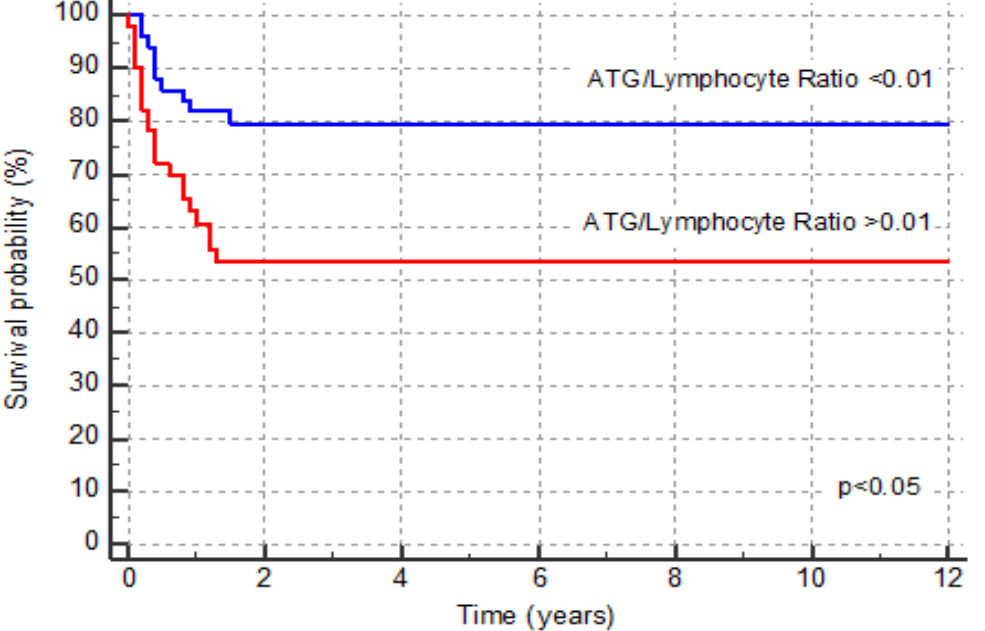
Figure 2. Kaplan–Meier curves for overall survival of patients in the low ATG/lymphocyte ratio group (blue line) and high ATG/lymphocyte ratio group (red line). Table 3. Multivariate proportional hazards regression analysis for overall survival.